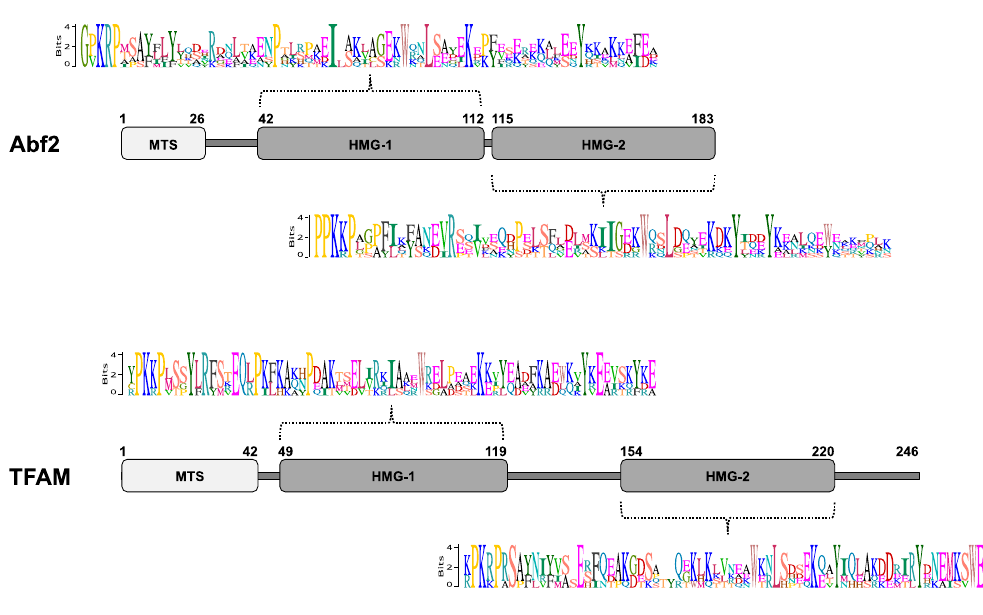
Figure 1. The domain organization of yeast (Abf2) and human (mitochondrial transcription factor A (TFAM)) HMG-box containing proteins (mtHMG) proteins. The amino-acid sequences of the two HMG-box domains of Abf2 (from S. cerevisiae , S. uvarum , Candida glabrata , Naumovozyma castellii , N. dairenensis , and Vanderwaltozyma polyspora ) and TFAM (from human, mouse, rat, Xenopus laevis , and Drosophila melanogaster ) were predicted using Simple Modular Architecture Research Tool (SMART) [148] and aligned using multiple sequence alignment software MAFFT (multiple alignment using fast Fourier transform) v7.450 [149]. The sequence logos were created using Geneious v11.1.5 (Biomatters). The mitochondrial targeting sequences (MTS) are based on experimental evidence [58,76].